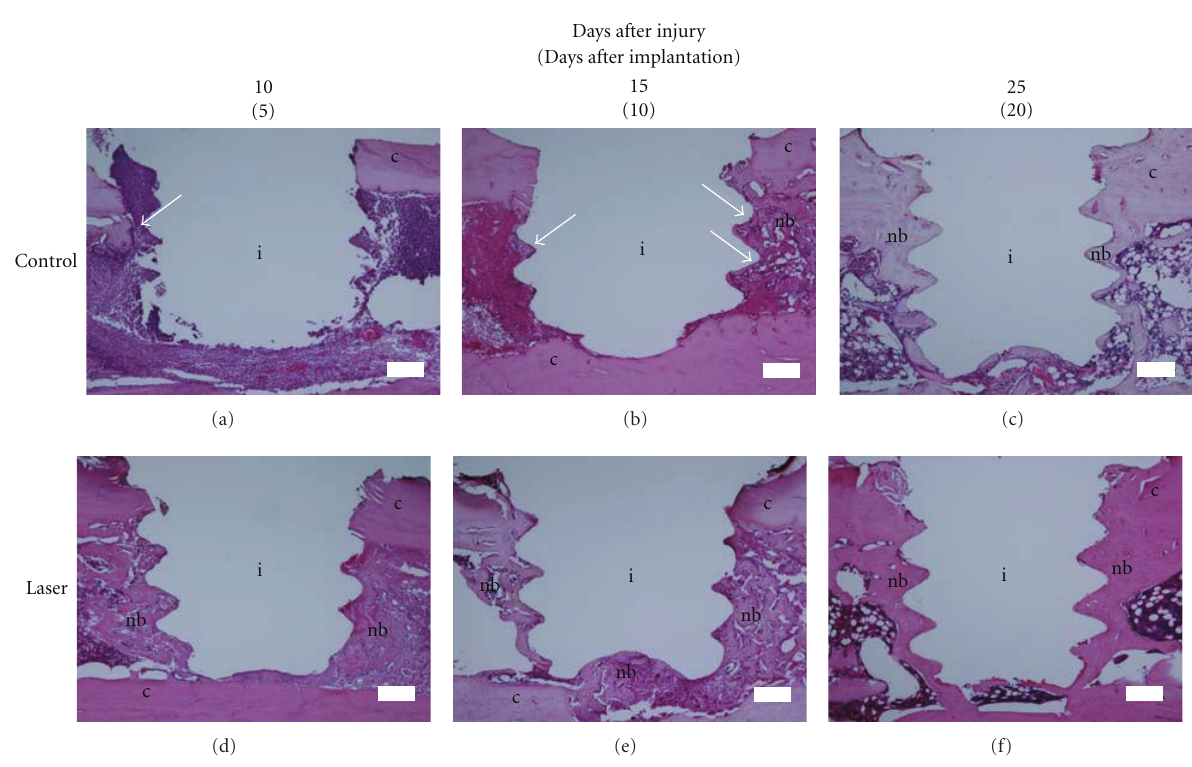
Figure 5: H&E staining observation. (a, d): 5 days after implantation (10 days after sham operation or laser irradiation). (b, e): 10 days after implantation (15 days after sham operation or laser irradiation). (c, f): 20 days after implantation (25 days after sham operation or laser irradiation). (a–c): control group tibia. (d–f): laser group tibia. In the early healing period (10 days after injury), in the control group,